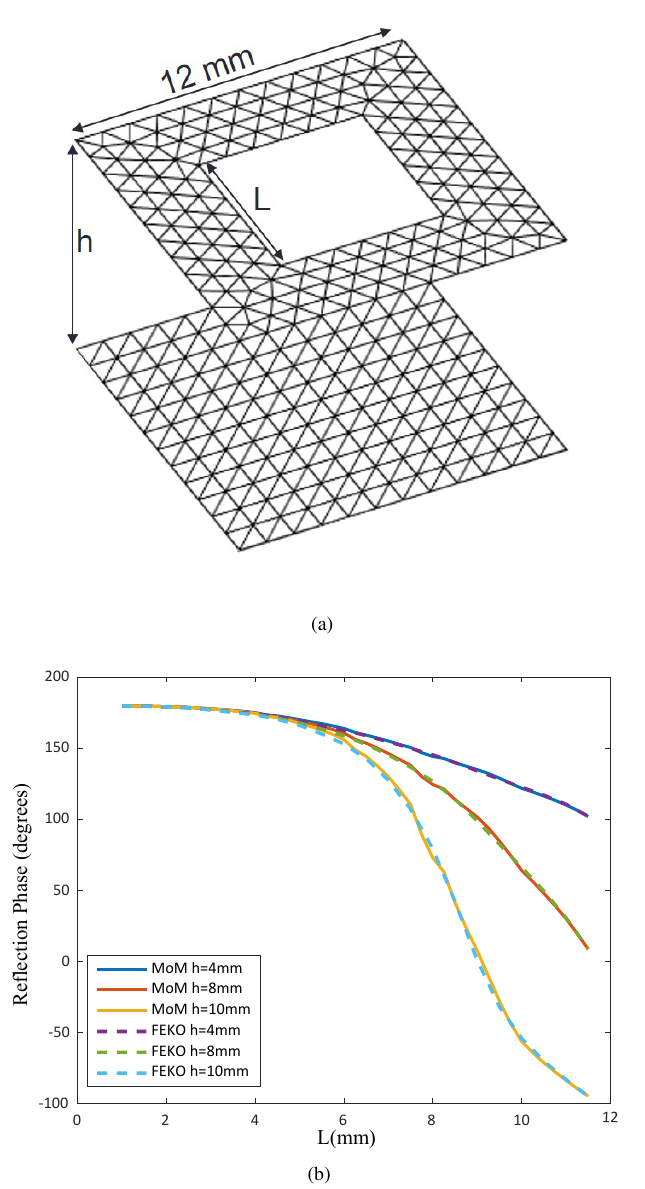
Figure 5: Square-slot reflectarray element. (a) The geometry and mesh. (b) The reflection phase.